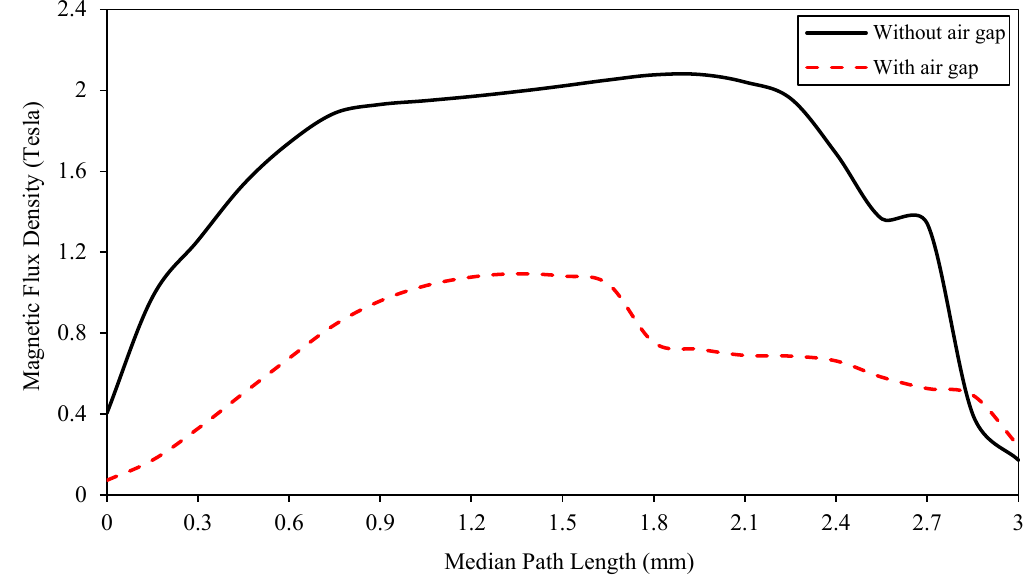
Figure 5. Magnetic field distribution along the imaginary median path.